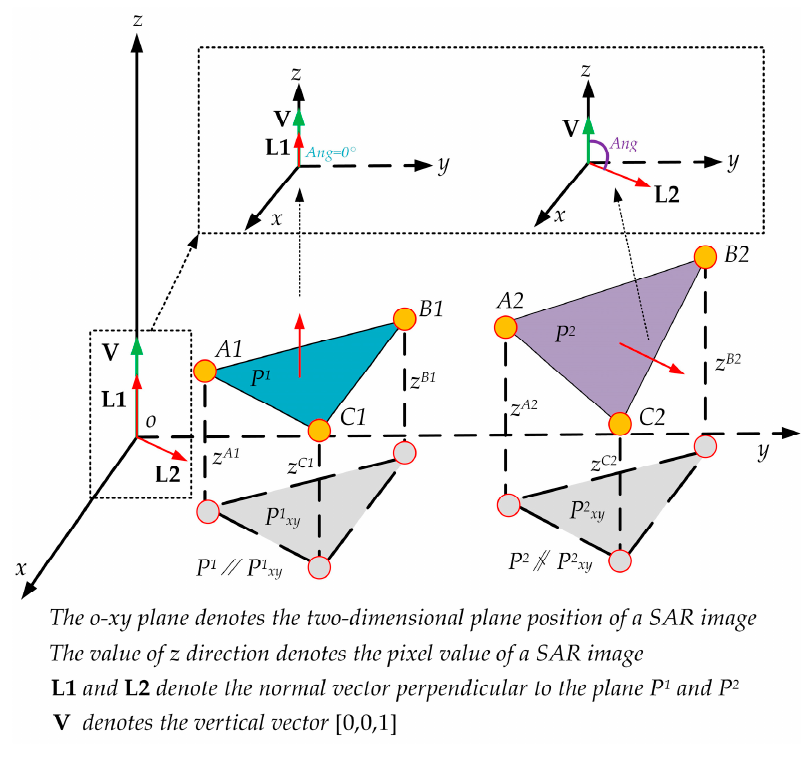
Figure 1. Local plane-inclination diagram.